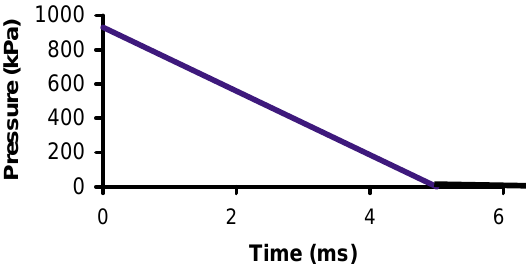
Fig. 11. Idealized blast pressure used for Example 4.